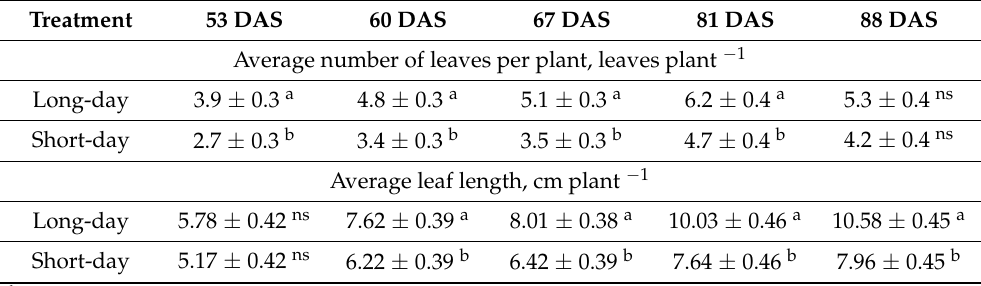
Table 1. Average number of leaves and average leaf length of yellow maca plants grown in rhizoboxes under controlled conditions at long (16 h) or short (8 h) day length. The measurements were performed at 53, 60, 67, 81, and 88 DAS. Results represent mean values ± SEM of three independent replicates. Treatment 53 DAS 60 DAS Average number of leaves per plant, leaves plant − 1